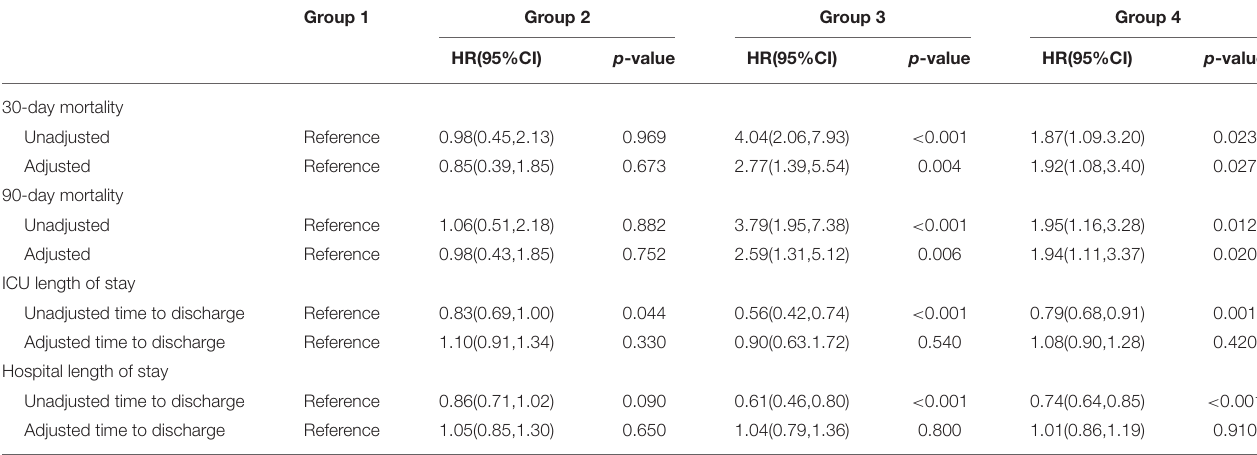
TABLE 2 | HRs (95% CIs) for all-cause mortality and length of stay across